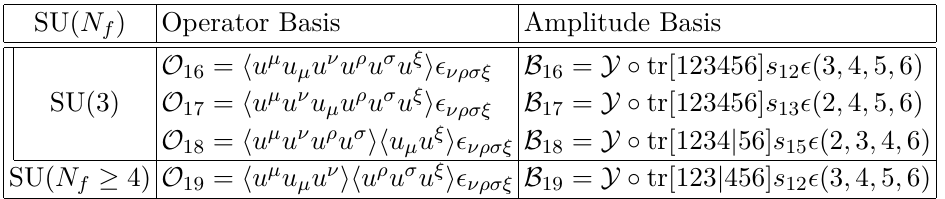
decreases. The corresponding operators f ( x ) by eq. (2.2). µ